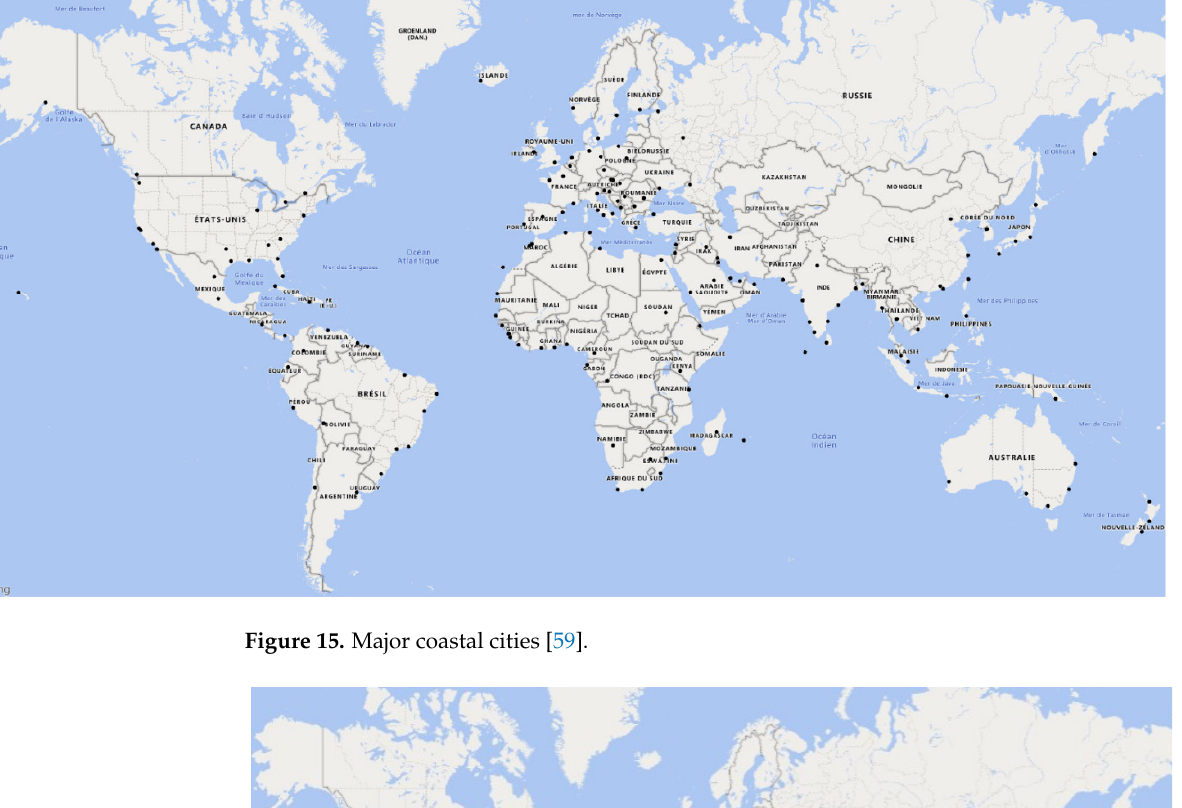
Figure 15. Major coastal cities [59].